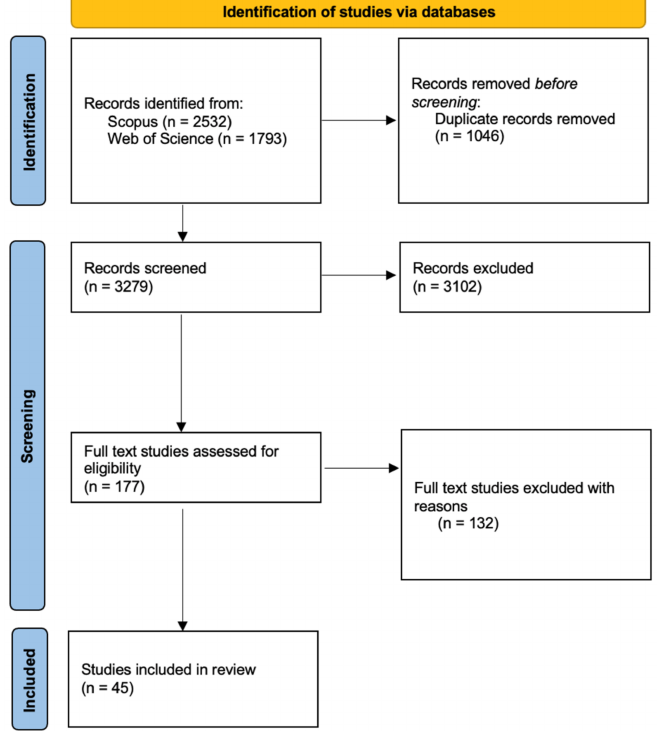
Figure 3. The Preferred Reporting Items for Systematic Reviews and Meta-Analyses (PRISMA) flowchart of this systematic literature review, based on the PRISMA 2020 guideline.